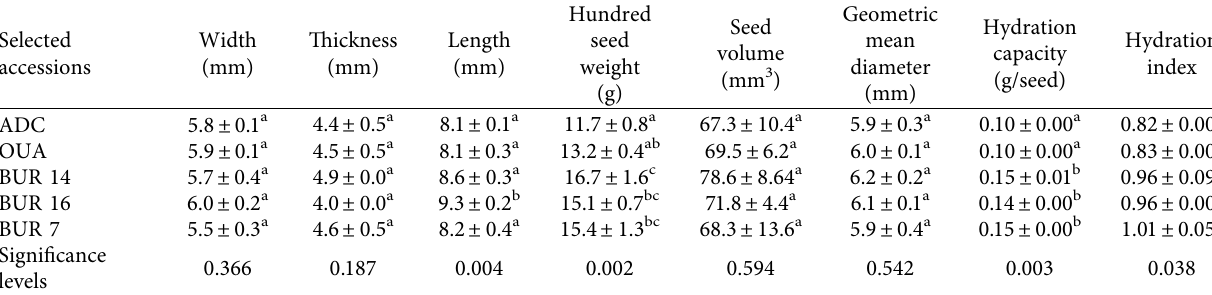
Table 2: Physical characteristics of Kersting’s groundnut seeds.